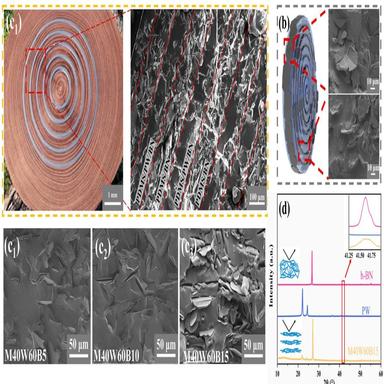
(a) Illustrations of PCMs with an annual ring structure; (b) SEM images of sections of the multilayered composite materials along and perpendicular to the blading direction; Cross-sectional images of M40W60Bx PCMs with different volume fractions: c1) 5 phr; c2) 10 phr; and c3) 15 phr; (d) XRD patterns of M40W60B15, pure PW, and randomly distributed BN.